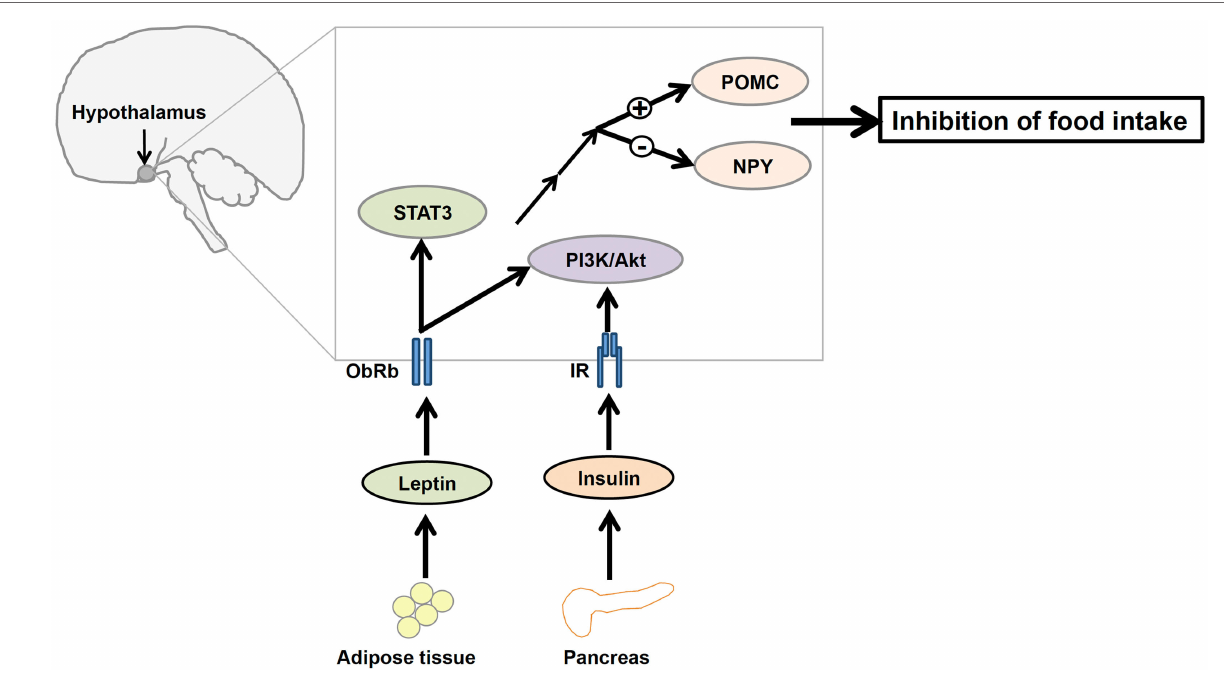
FiGURe 2 | A diagrammatic representation of the integration of leptin and insulin signals in the regulation of energy homeostasis in the central nervous system . Adipocyte-derived hormone leptin and pancreatic hormone insulin bind to leptin receptors (ObRb) and insulin receptors (IRs), respectively, in the hypothalamus. Leptin and insulin regulate the expression of proopiomelanocortin (POMC) and neuropeptide Y (NPY) neurons in the hypothalamus via the phosphatidylinositol 3-kinase/protein kinase B (PI3K/Akt) signaling pathway to suppress food